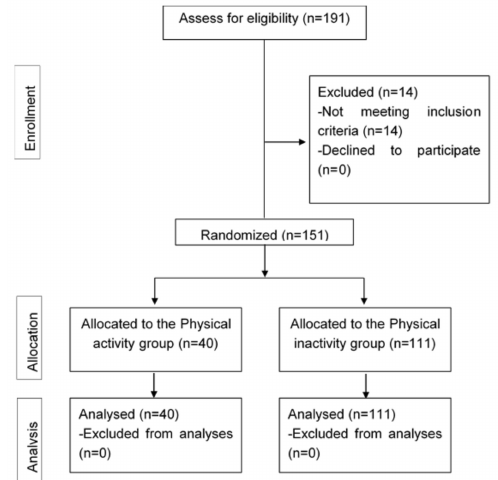
Figure 1. PRISMA flow chart of the